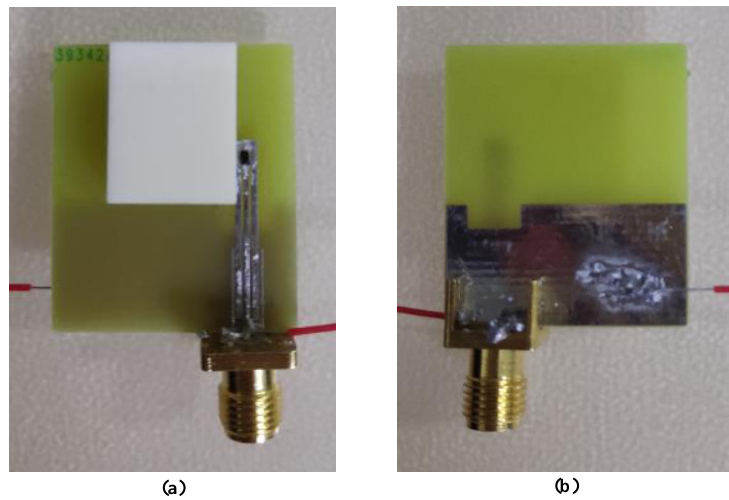
Figure 9. Prototype of the proposed DRA: ( a ) top view and ( b ) bottom view. Table 2. Final dimensions of the proposed antenna.